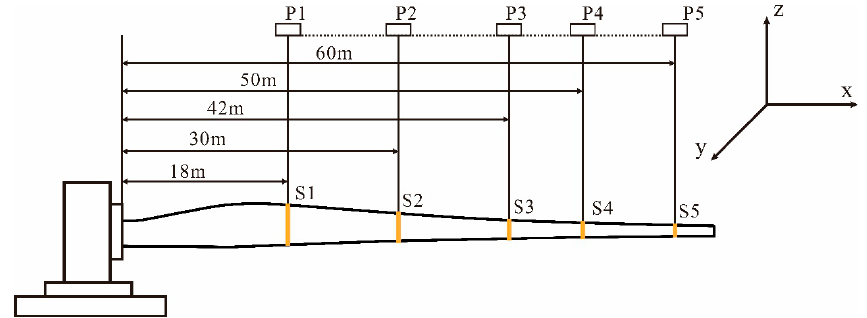
Figure 5. Applied loading diagram of the full-scale static testing.